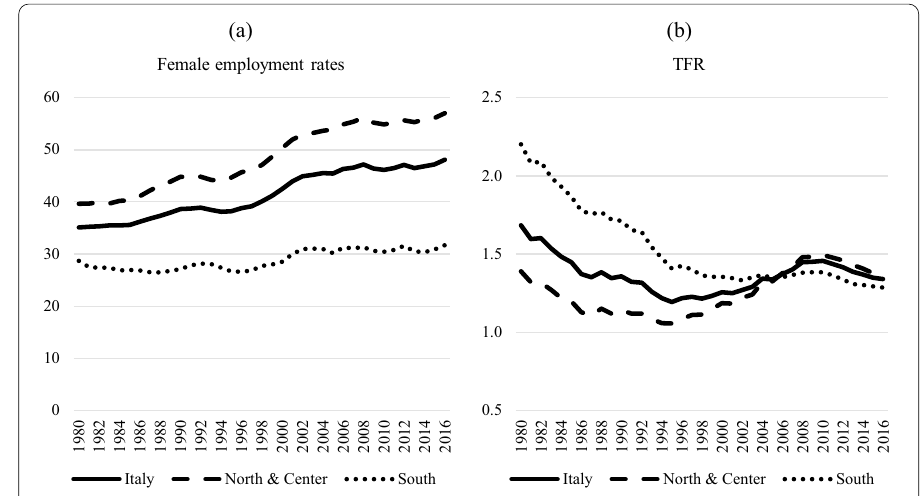
Fig. 1 Female employment rates ( a ) and total fertility rates ( b ) by macro-area, Italy, 1980–2016. Source: Author’s elaboration on ISTAT